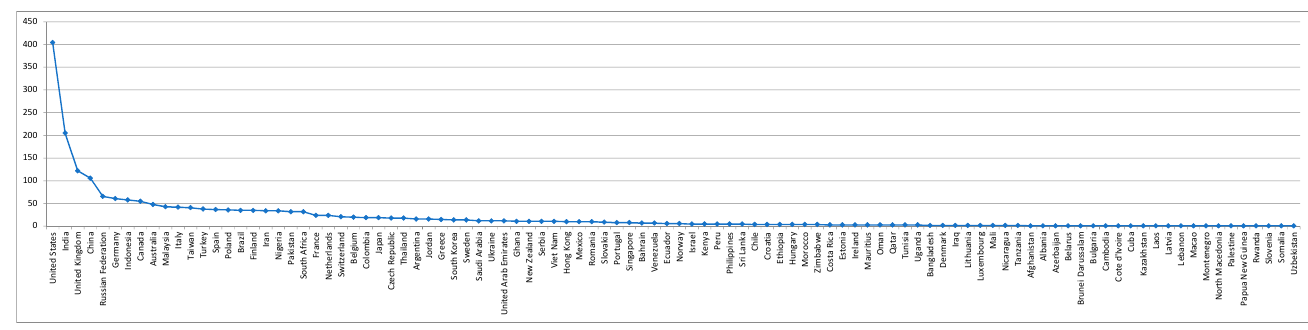
Figure 6. Distribution of records by country (Scopus).